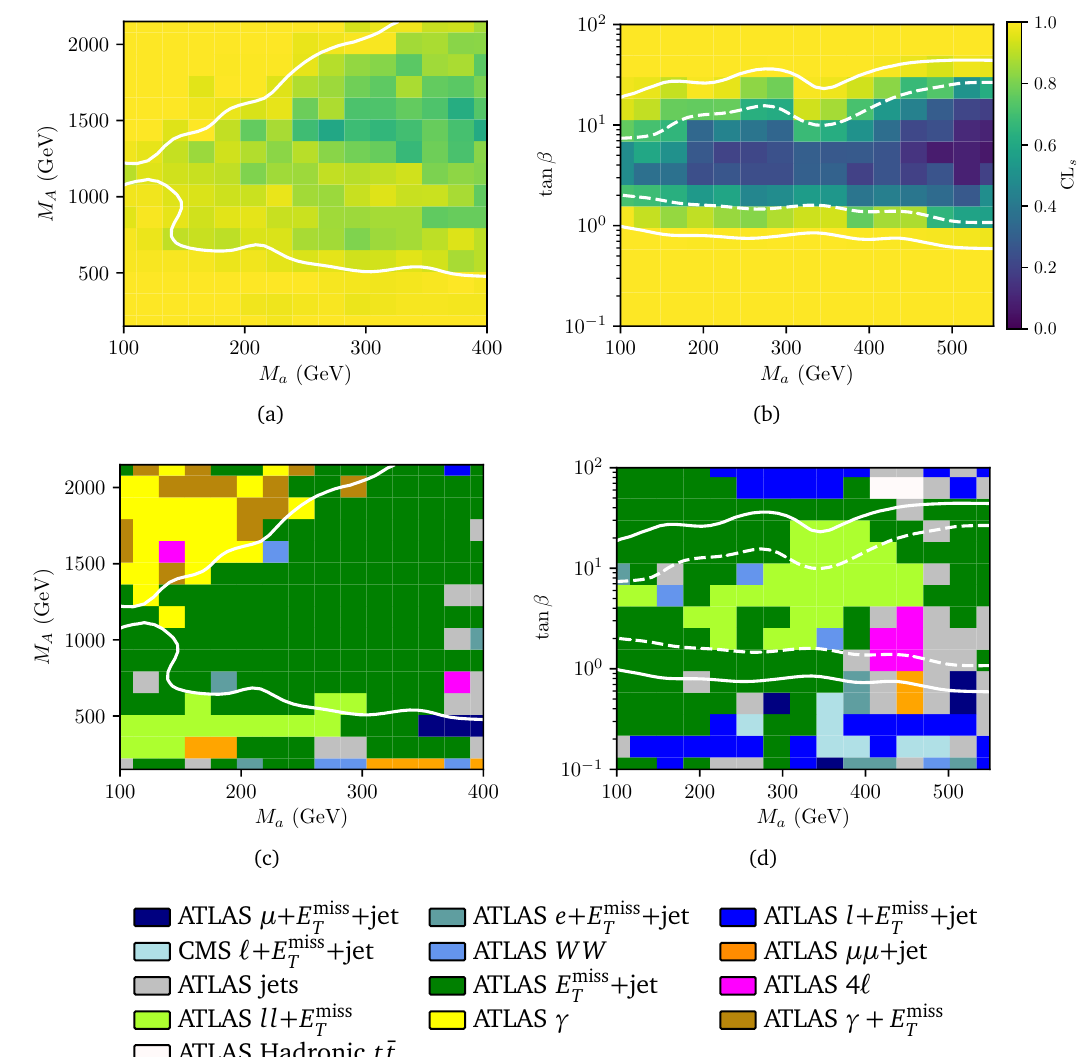
Figure 6: C ONTUR scans over the parameter planes from [ 4 ] but with the maximal mixing assumption sin θ = 1 / planes. All other parameters are as given in Table 1. The top row shows the sen- sitivity map in terms of CLs, with 95% (68%) excluded contours indicated by solid (dashed) white lines; note that the whole plane in M fidence level. The bottom row shows the analysis which contributes the most to the sensitivity of each signal